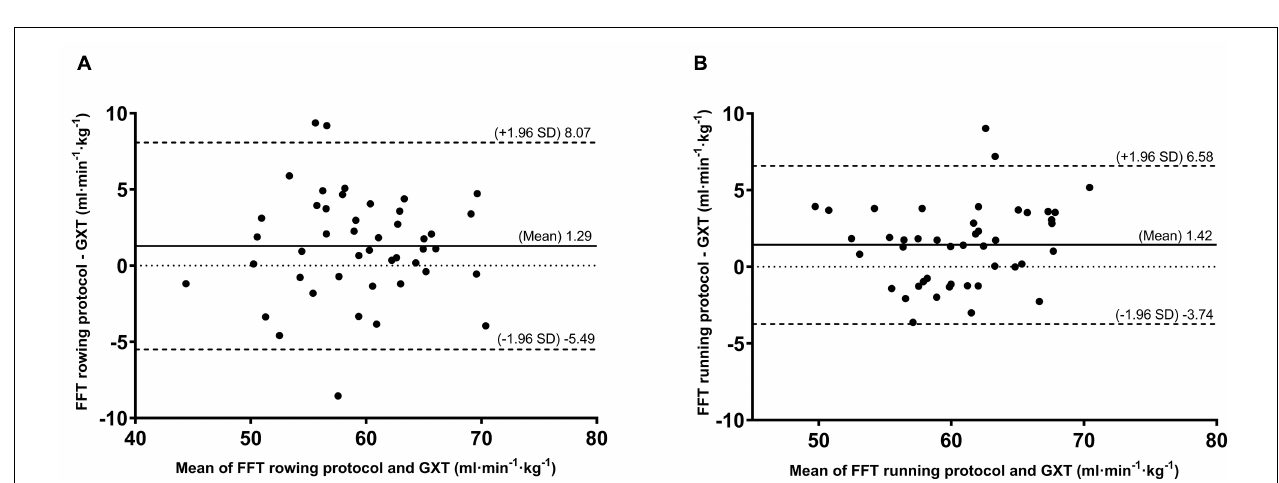
FIGURE 3 | Bland-Altman plots between the estimated VO 2max from FFT and measured VO 2max by GXT. (A) The FFT rowing program and (B) The FFT running program. Mean biases (solid line), ± 95% limits of agreement (dashed line), and equality (dotted line) are also